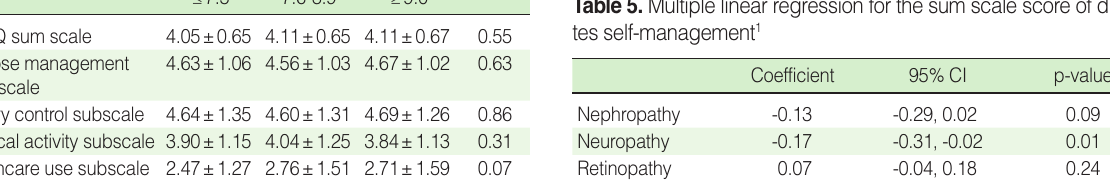
Table 3. DSMQ self-care activity scores depending on HbA1c values DSMQ